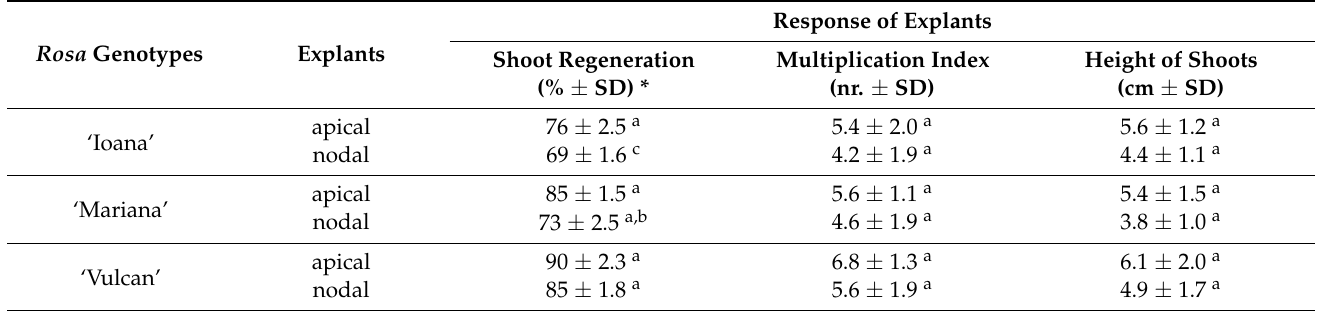
Table 1. The morphogenetic response according to explant